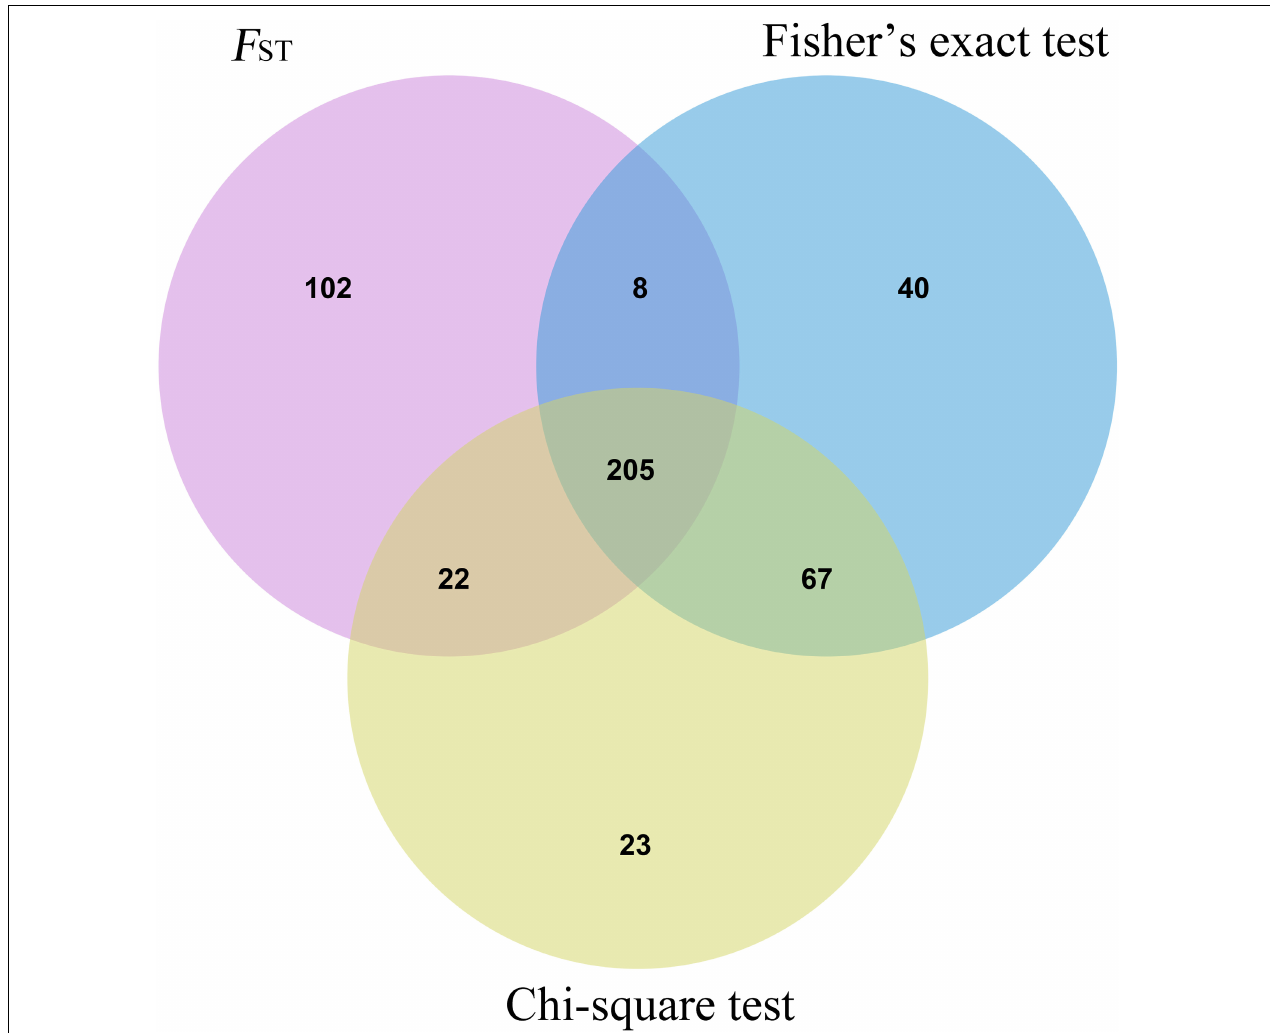
FIGURE 3 | Shared SNP sites Venn diagram of three statistical